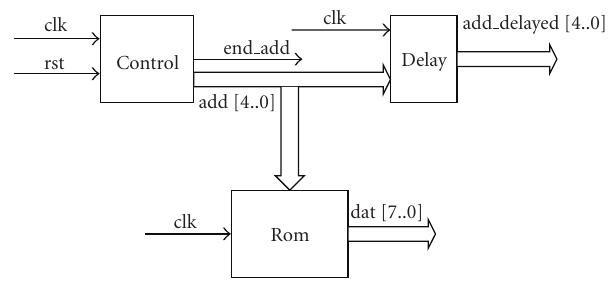
Figure 6: Schematic circuit of ROM unit.